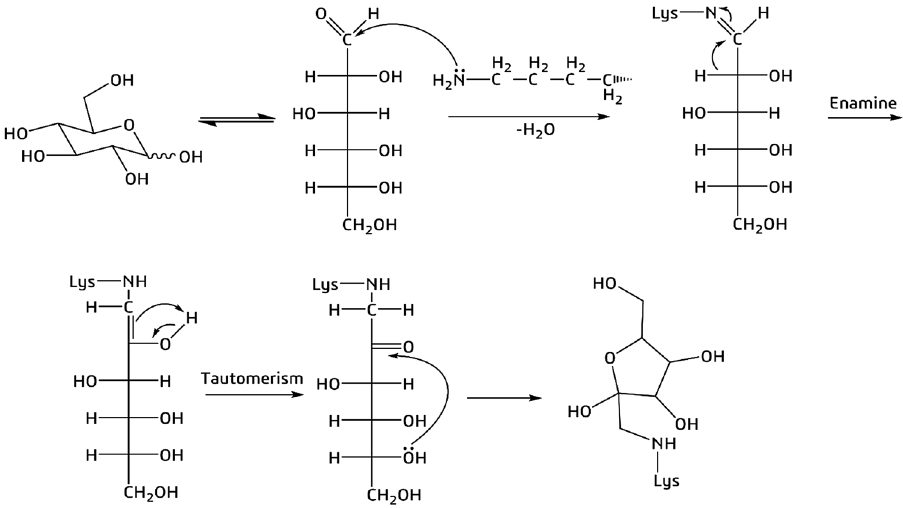
Figure 1. Mechanism of non-enzymatic glycation of a lysine amino acid residue by d-glucose. The final product is the cyclic amino sugar that we considered for the